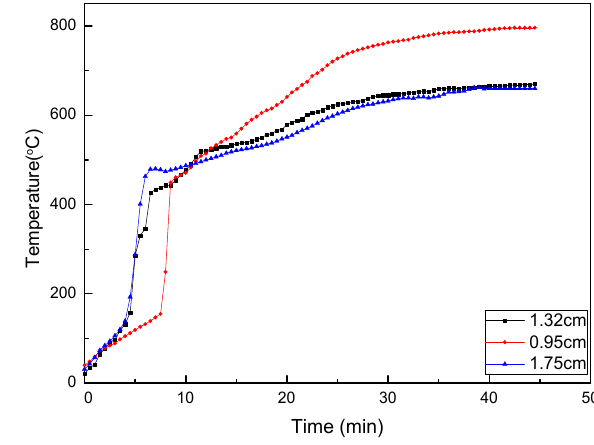
Figure 8: The temperature curve of different microwave power.